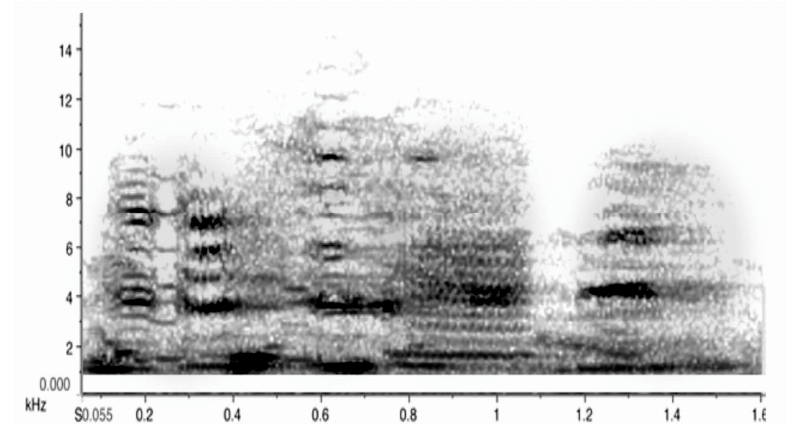
Figure 6. A 1.6 sec excerpt of a group chorus by three magpies in overlapping carolling bouts. Note that the sound is almost continuous and very noisy (fuzzy grey) but it still has strong energy in the 4–6 kHz range. It is of high intensity measured at 90–100 dB at 10 m distance, (similar in intensity to the sound of a jackhammer or a fast-moving freight train). The loudest territorial duets and choruses in land animals are usually associated with primates. In howler monkeys, for instance, these have been measured at around 6–7 kHZ and 88 dB at a 5-m distance [37], with similar readings of duets or choruses in other primates [38–40]. In magpies, I have measured magpie group choruses at 90 dB and even 100 dB at a distance of 10 m.